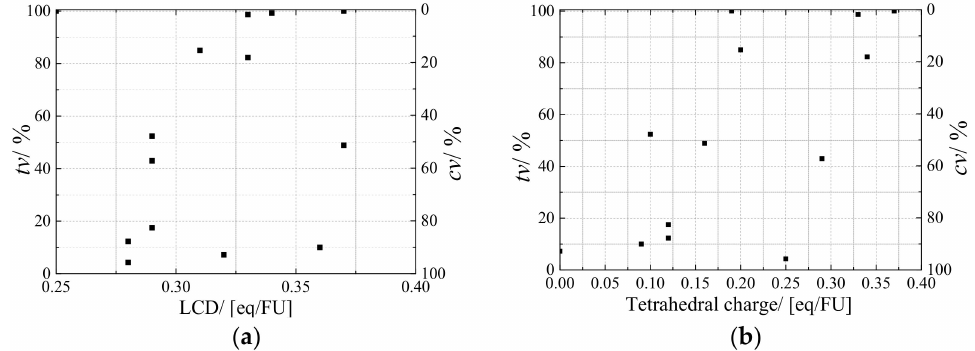
Figure 12. Relationship of the proportion of tv and cv layers to ( a ) layer charge density (LCD) and ( b ) tetrahedral